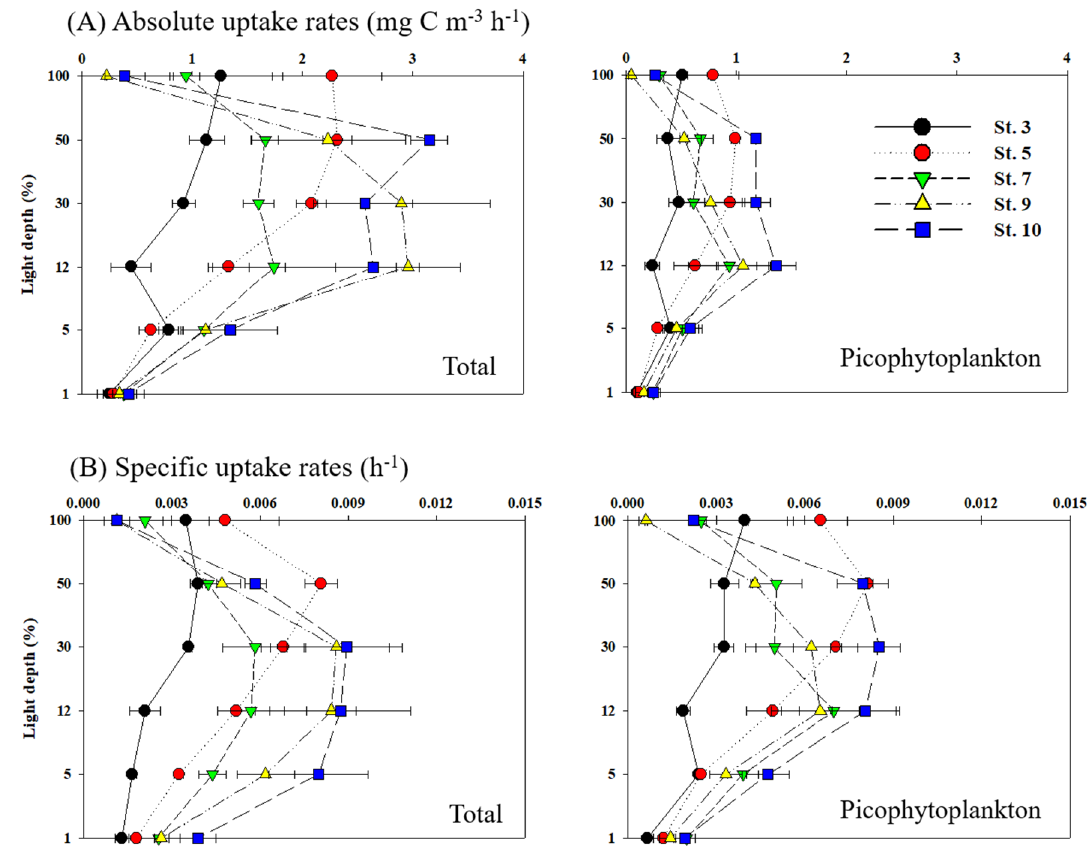
Figure 5. The vertical pattern of ( A ) absolute and ( B ) specific carbon uptake rates for total and picophytoplankton at each light depth (100, 50, 30, 12, 5, and 1% light depth).